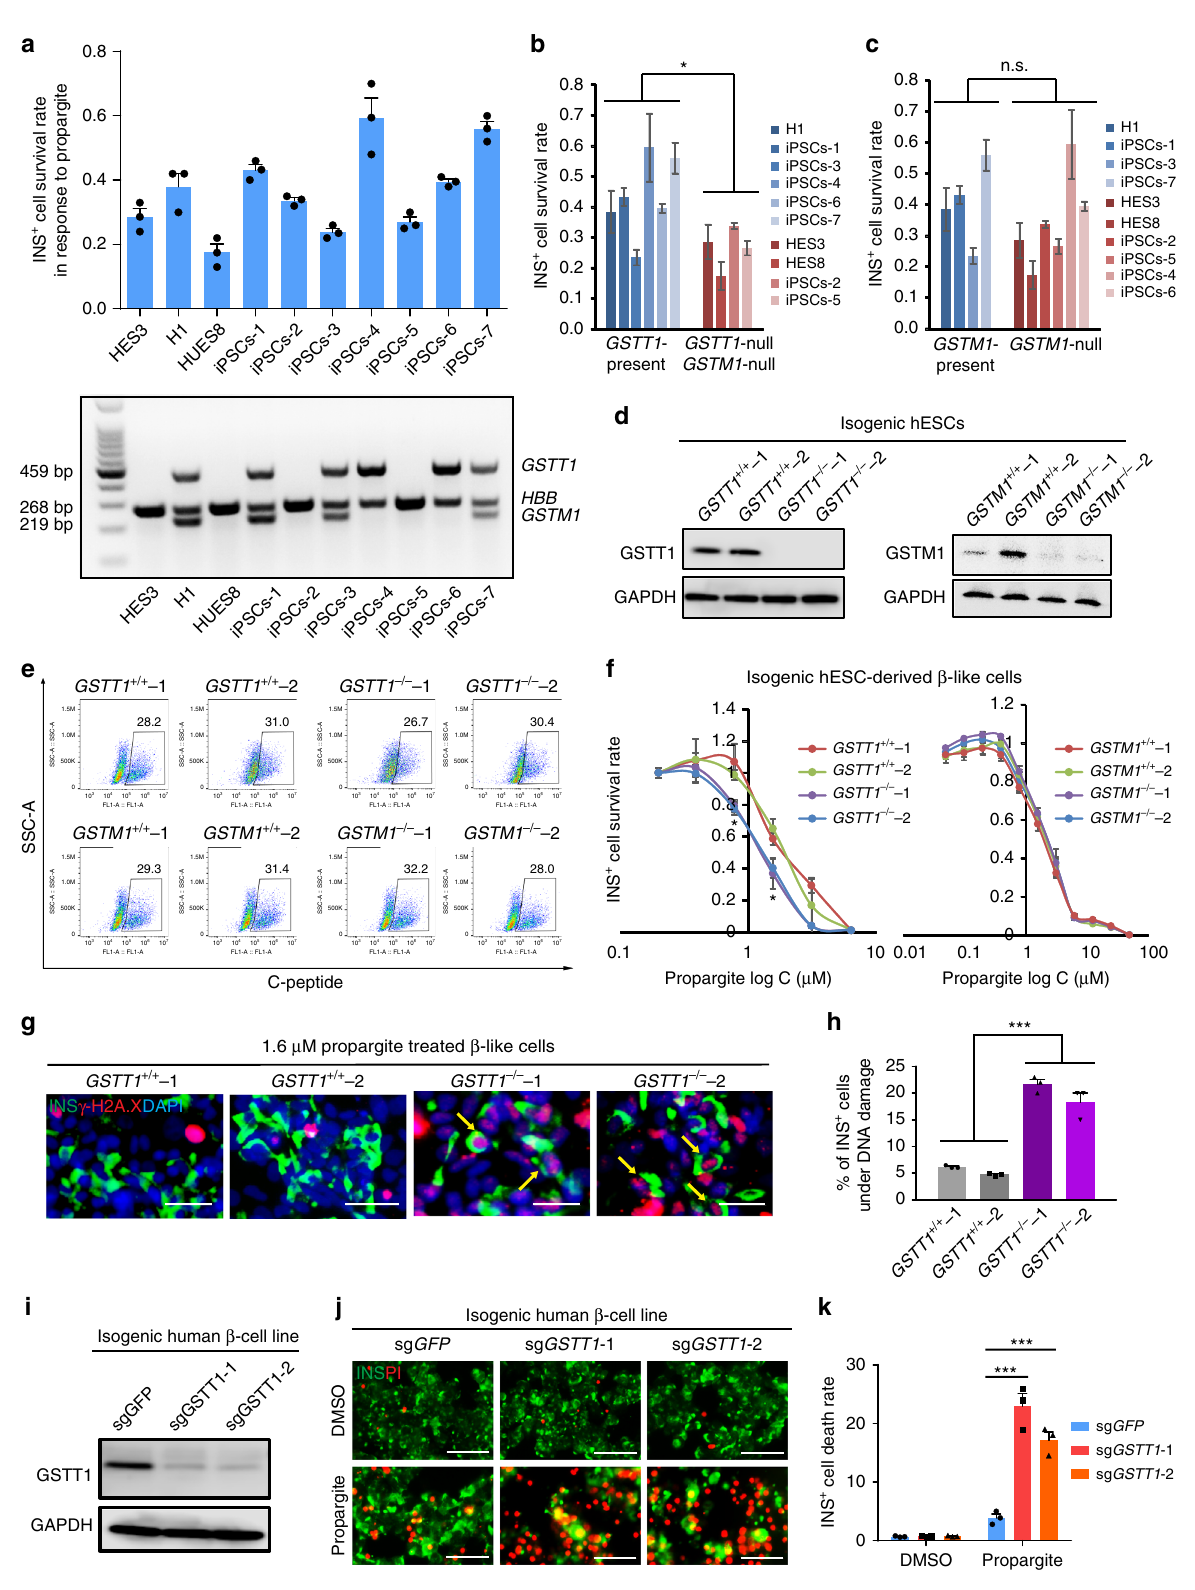
de fi cient mice. EndoC- β H1-Luc cells carrying sg GFP were used